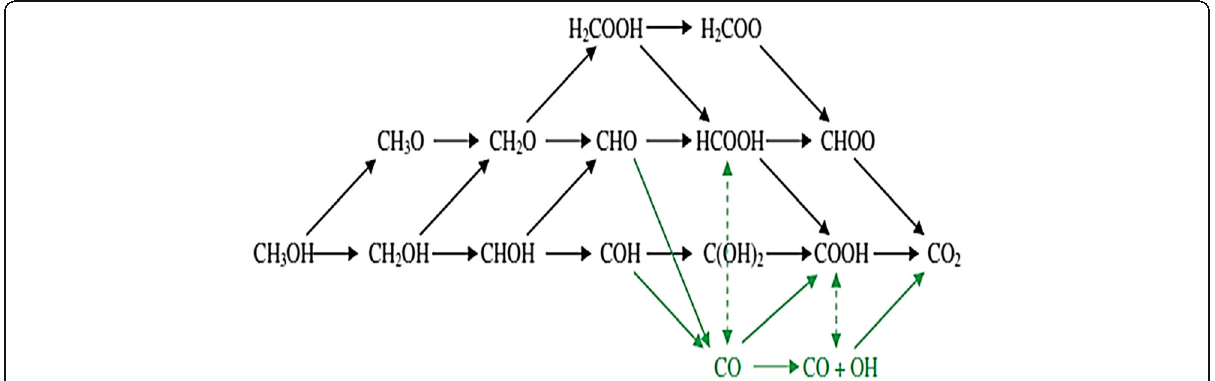
Fig. 10 Schematic of the reaction paths and possible intermediates molecules considered in methanol electrooxidation